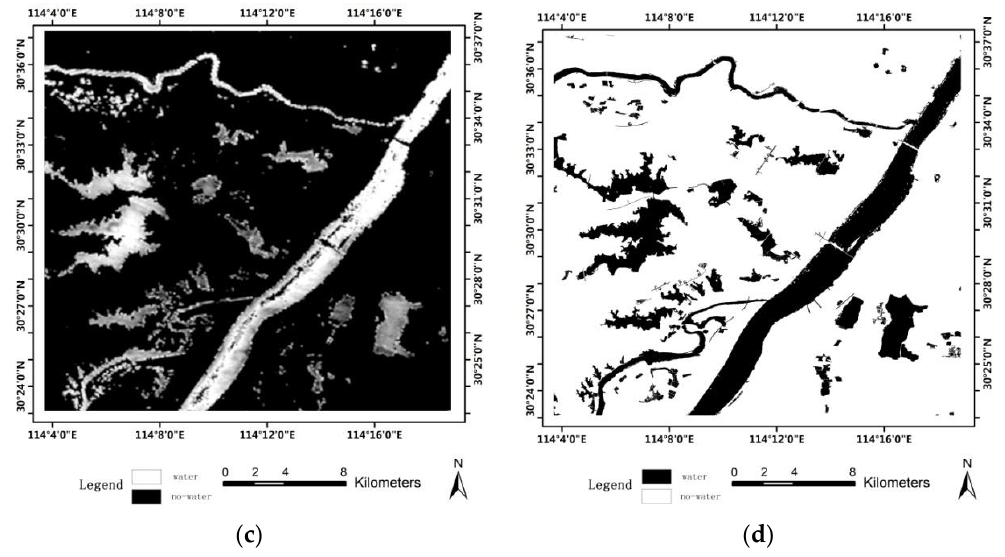
Figure 7. Salience map comparison and segmentation result (Changjiang River). ( a ) original SAR image; ( b ) the saliency map generated by Itti model; ( c ) the saliency map generated by TW-Itti model; ( d ) LSW map obtained using our method.